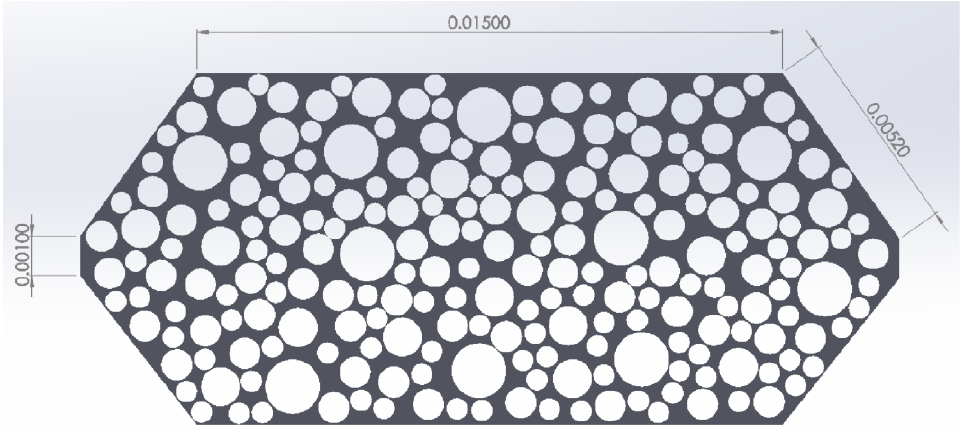
Figure 2. The geometry of the micromodel that was considered. Taber et al. [38] curated a list of screening criteria for different EOR methods. The recommended porosity for immiscible gas flooding was <0.6. With this in consideration, the geometry was built by randomly distributing 220 circles with different diameters in the domain of the porous medium. Table 1 shows the size distribution of the circles used to form the porous medium. A porosity of 0.4 was obtained by subtracting the surface area of the circles from the main domain. Inlet and outlet ports are displayed on the left and right sides of the geometry, respectively. The dimensions of the model were 21 cm in length and 9 cm in height. The inlet and outlet were each 1 cm long. The model was oriented horizontally to minimize the effects of